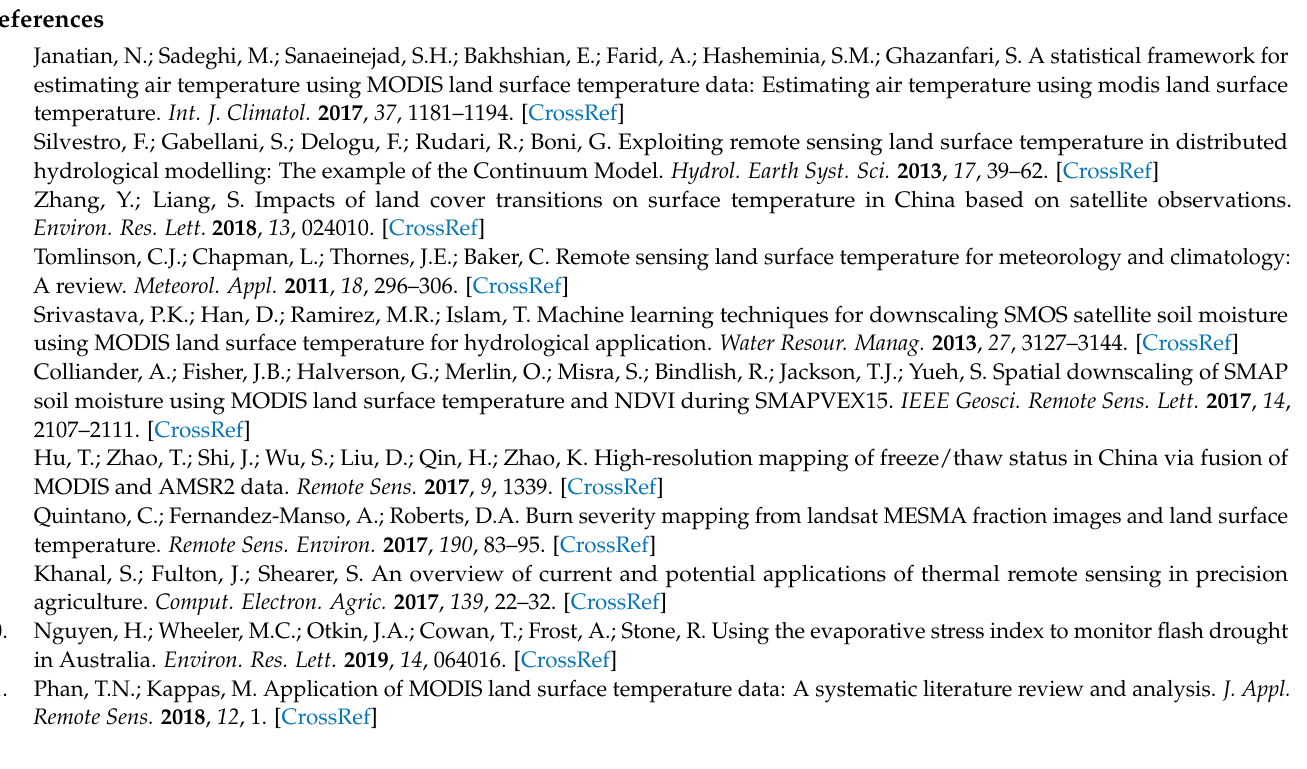
Table A3. Comparison of the MLP-GTWR LSTcor and the downscaled LST using Shwetha’s method [32] against the in-situ measure- ments at four flux towers. The statistical metrics at each site are shown.